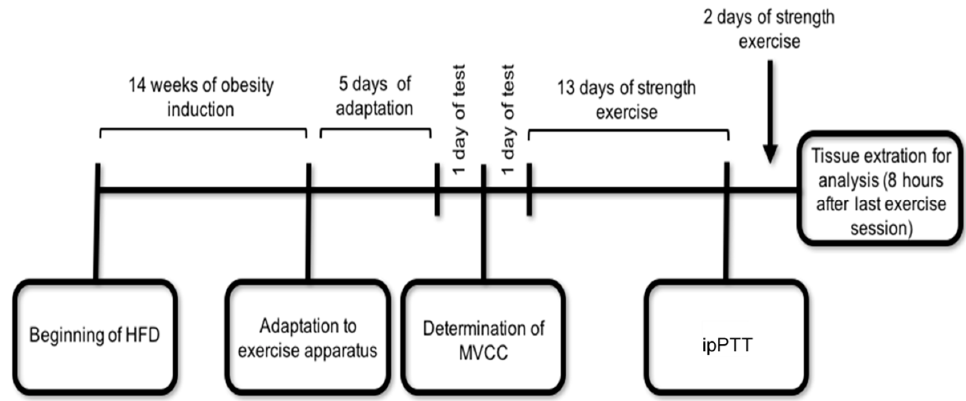
Figure 6. Schematic representation of the experimental design. The ipPTT and tissue extraction were performed 8 h after the exercise session and 8-h fasting. HFD = High Fat Diet; MVCC = Maximum Voluntary Carrying Capacity; ipPTT = intraperitoneal Pyruvate Tolerance